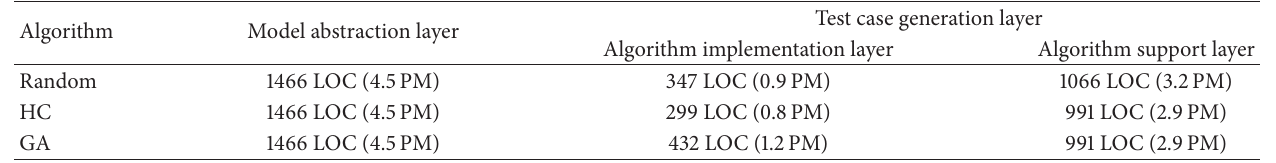
Table 3: Source code sizes and efforts of each algorithm (using SL/SF model).